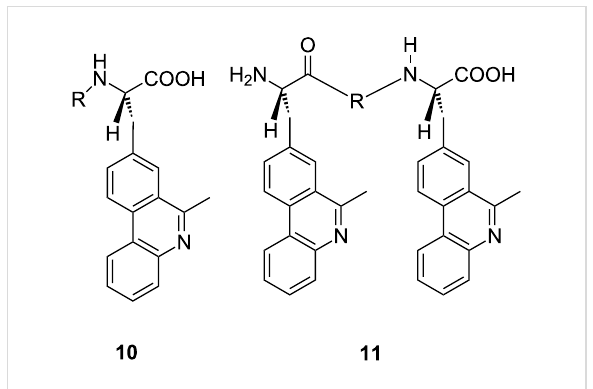
Figure 4: Series of amino acid–phenanthridine building blocks (general structure 10 ; R = H; Gly) and peptide-bridged bis-phenanthri- dine derivatives (general structure 11 ; R = X; Gly; Gly–Gly) [68].